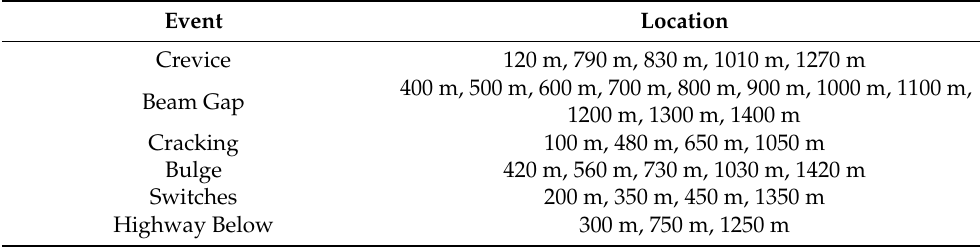
Table 1. Event distribution without ‘no-event’. (Position of 0 m: the end near the computer room; Position of 1500 m: the other